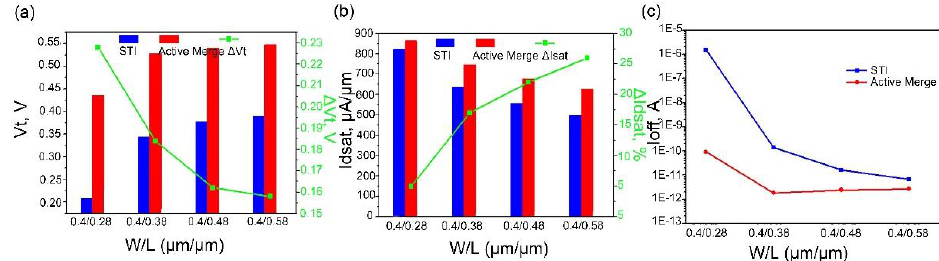
Figure 9. The effect of the merged active area on ( a ) Vt, ( b ) I dsat , and ( c ) I off in a single transistor.